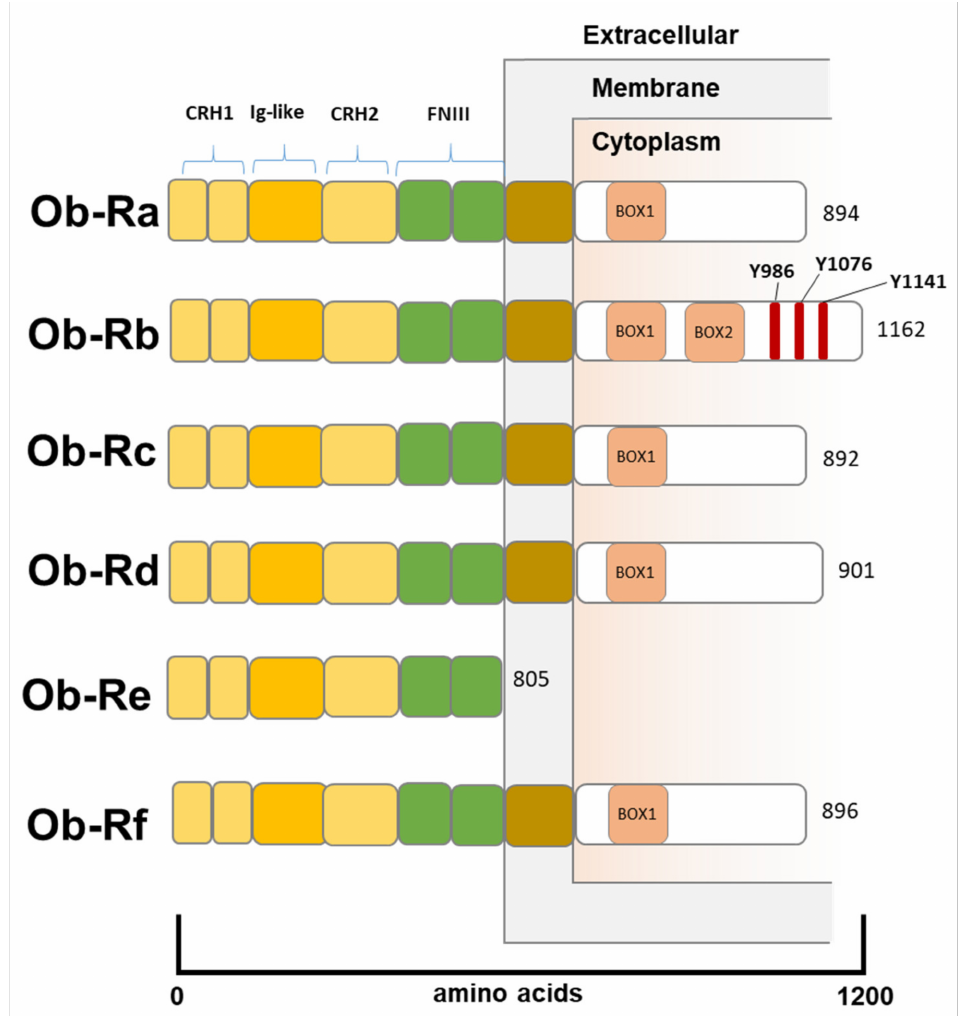
Figure 1. The Structure of Leptin Receptors. All leptin receptor isoforms share a binding C-terminal extracellular domain consisting of 2 CRH regions separated by an IG-like domain and followed by 2 FNIII domains. The intracellular N-terminal domain presents a BOX-1 motif, which is critical for JAK-2 binding. OB-Rb receptor is the only isoform to present a BOX-2 motif, which facilitates the activation of JAK2-STAT transduction pathway. Additionally, OB-Rb presents 3tyrosine residues (Tyr986, Tyr1076, and Tyr1141) whose phosphorylation enables STAT3-5 activation. OB-Re receptor is a soluble isoform, which binds circulating LEP and regulates LEP plasma bioavailability and functionality, not being able to transduce any downstream signal. CHR, cytokine receptor homology; IG-like, immunoglobulin-like; FNIII, fibronectin type